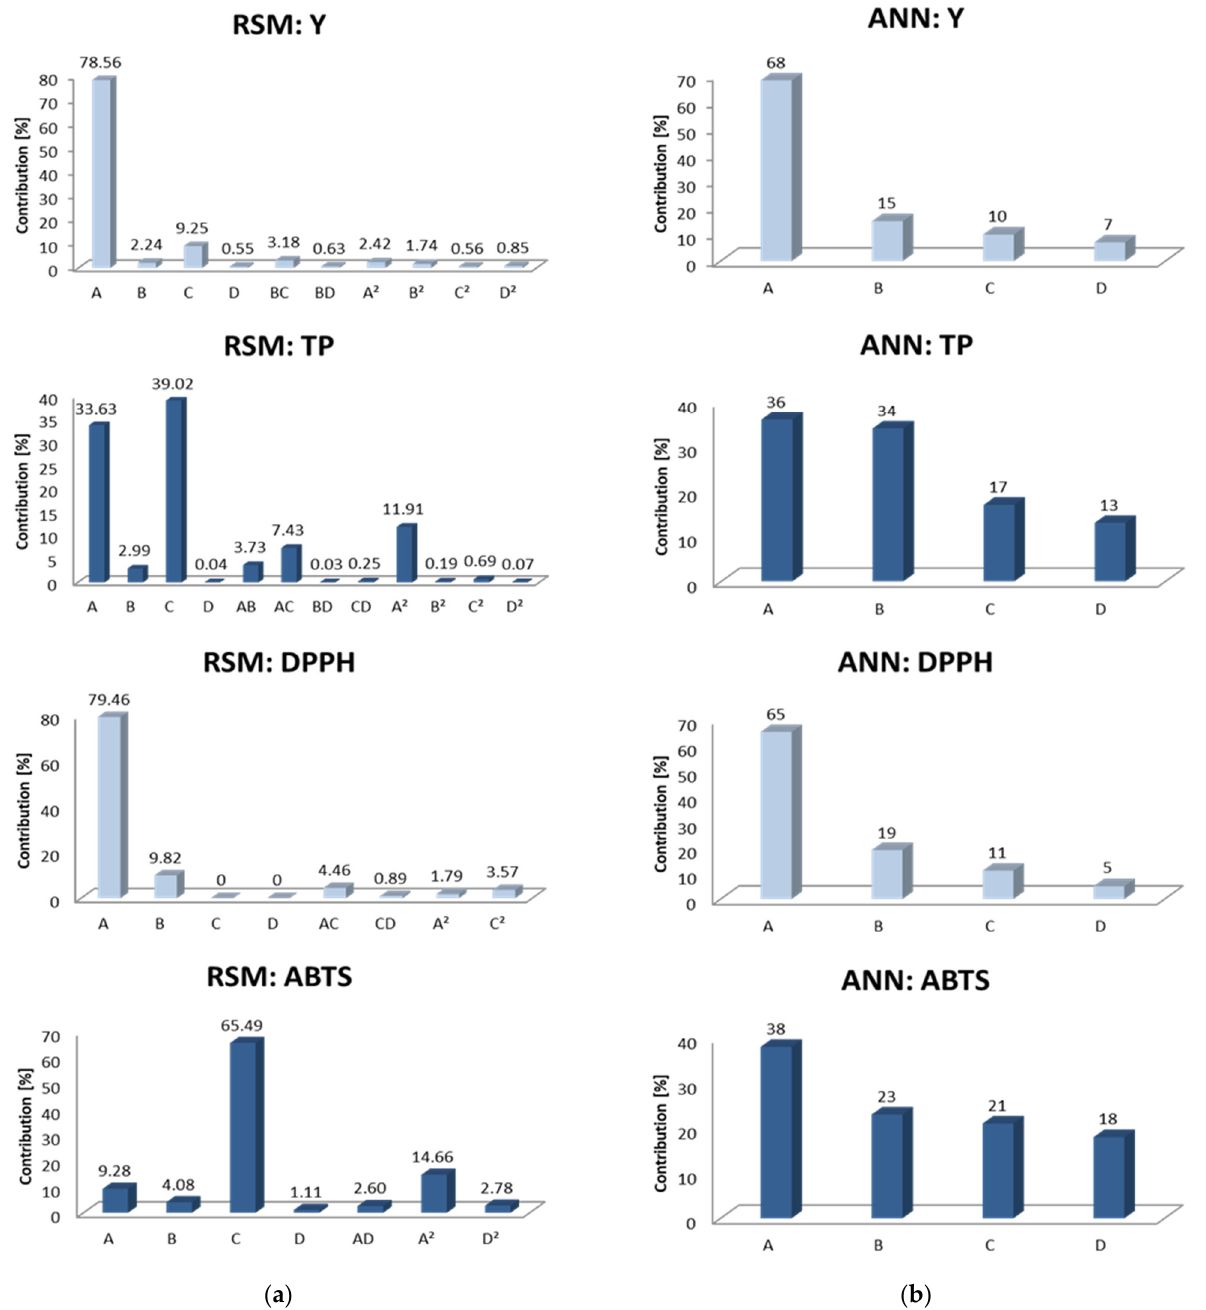
Figure 2. Contributions of ethanol concentration (A), extraction time (B), liquid–solid ratio (C) and irradiation power (D) observed by ( a ) RSM and ( b ) ANN.